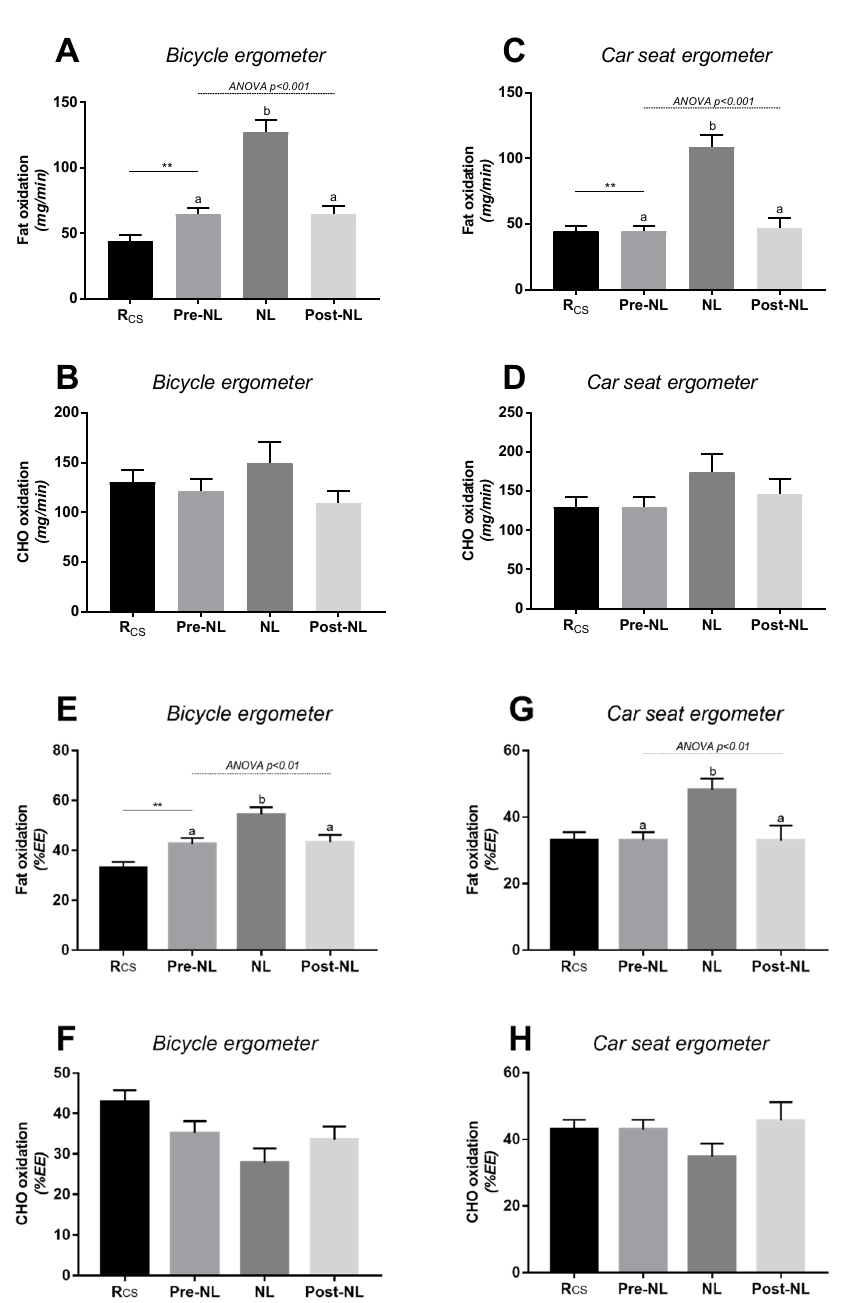
Figure 3. Substrate oxidation rates at rest and in response to no-load (NL) cycling using the bicycle ergometer (panels A , B ) or the car seat ergometer (panels C , D ). Rcs = at rest while sitting in car seat ergometer; NL = no-load cycling: sitting (car seat or bicycle) and cycling at 60 rpm at no-load; pre-NL and post-NL: at rest while sitting in car seat or bicycle with feet on pedals before and after no-load cycling, respectively; CHO: carbohydrates; EE: energy expenditure. Values are mean ± SEM. In Figure 3 A – D the data of substrate oxidation are expressed as mg/min, while in Figure 3 E – H , they are expressed as a percentage of energy expenditure (%EE). An ANOVA test was applied across pre-no-load, no-load, and post-no-load, followed by post hoc pairwise comparisons using Tukey’s test; values with different superscripts (a, b) are significantly different from each other ( p < 0.05). A paired t -test was applied for comparing pre-NL vs Rcs; **: significant difference at p < 0.01. The results of this experiment investigating the changes in EE, RQ, HR, and RPE across very low- to low-intensity cycling exercise on the bicycle ergometer are shown